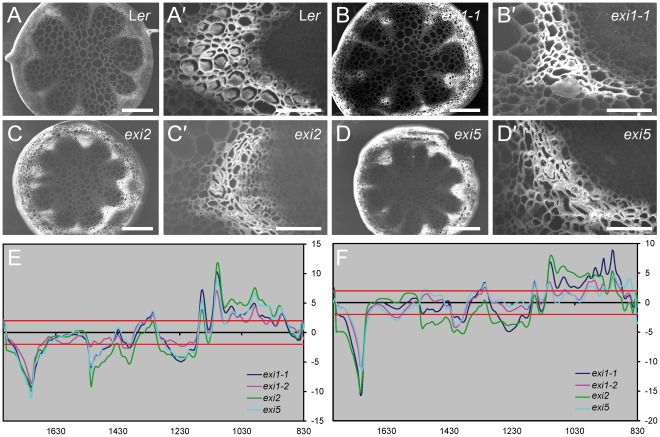
Xylem structure and composition in exi stems.(A–D) Scanning electron micrographs of transverse sections of stems from (A, A′) Ler, (B, B′) exi1-2, (C, C′) exi2 and (D, D′) exi5 plants. Magnification is (A–C) 70x and (A’–C’) 500x. (E–F) Comparison of the Fourier transform infrared spectroscopy spectra obtained from stem sections of Ler and exi plants. Spectra were acquired on xylem in apical (E) and basal (F) parts of the stem. The value between the two red lines (threshold) corresponds to non-significant differences (P value<0.01) between the two genotypes tested. Significant positive t-values indicated a higher absorbance value in Ler than in the exi mutants.